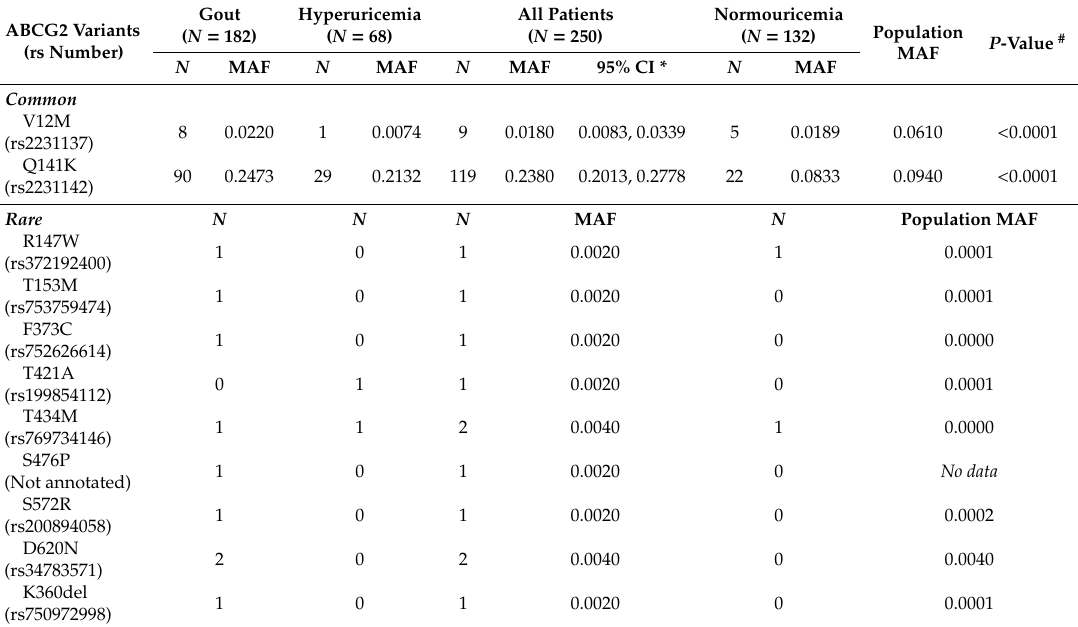
Table 2. Identified ABCG2 variants and their mutant allele frequency.